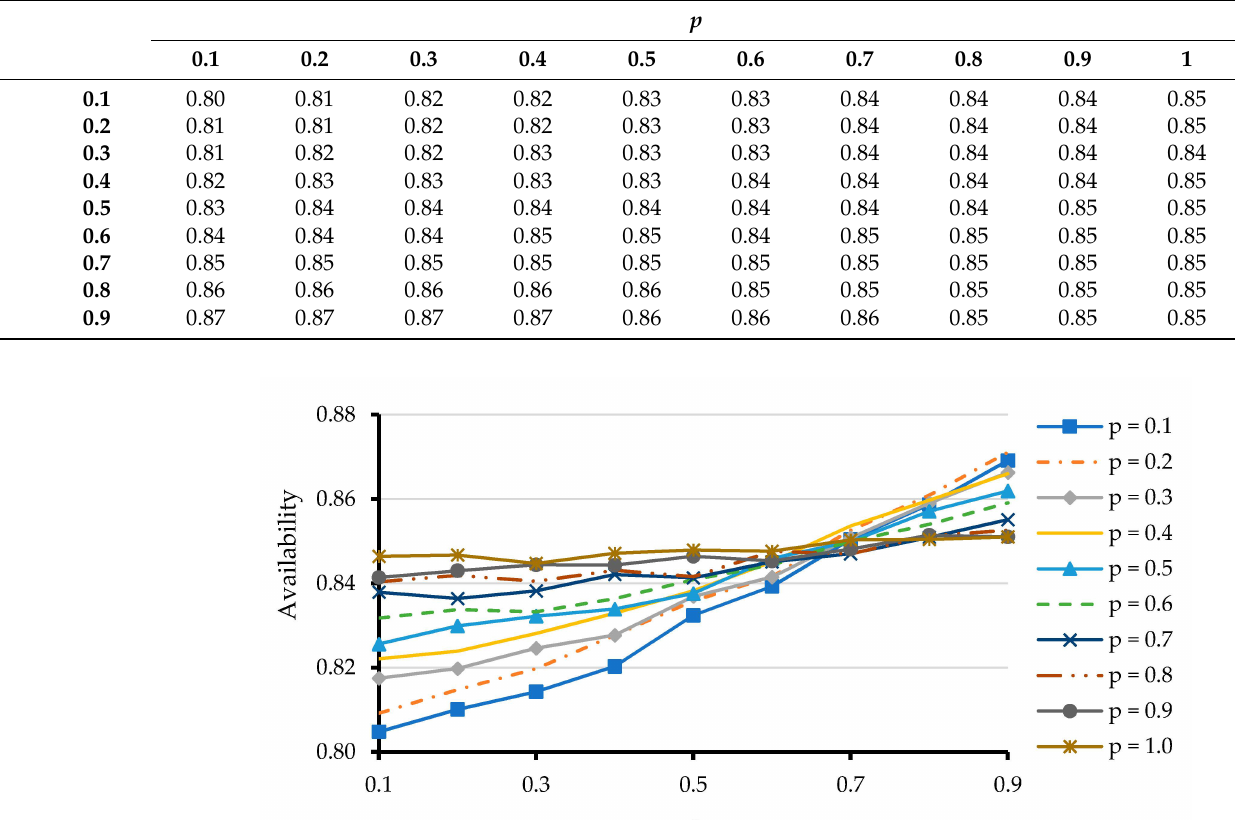
Table 11. Availability of the total system for different q and p (in MEUR). Matrix representation.